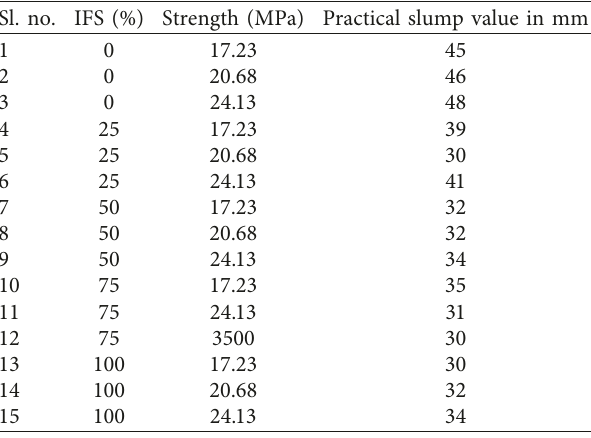
Table 4: Slump value for concrete with different IFS ratio. Sl. no. IFS (%) Strength (MPa) Practical slump value in mm